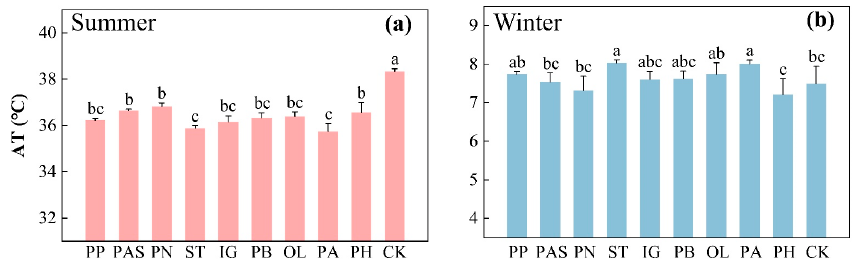
Figure 3. The average daily AT of the different bamboo communities and the CK in summer ( a ) and winter ( b ). The letters above the columns are multiple comparisons between the different communities (Tukey significant difference test; different letters mean significant differences, p < 0.01). Table 2. Comparison of AT and ST in the different communities in summer.